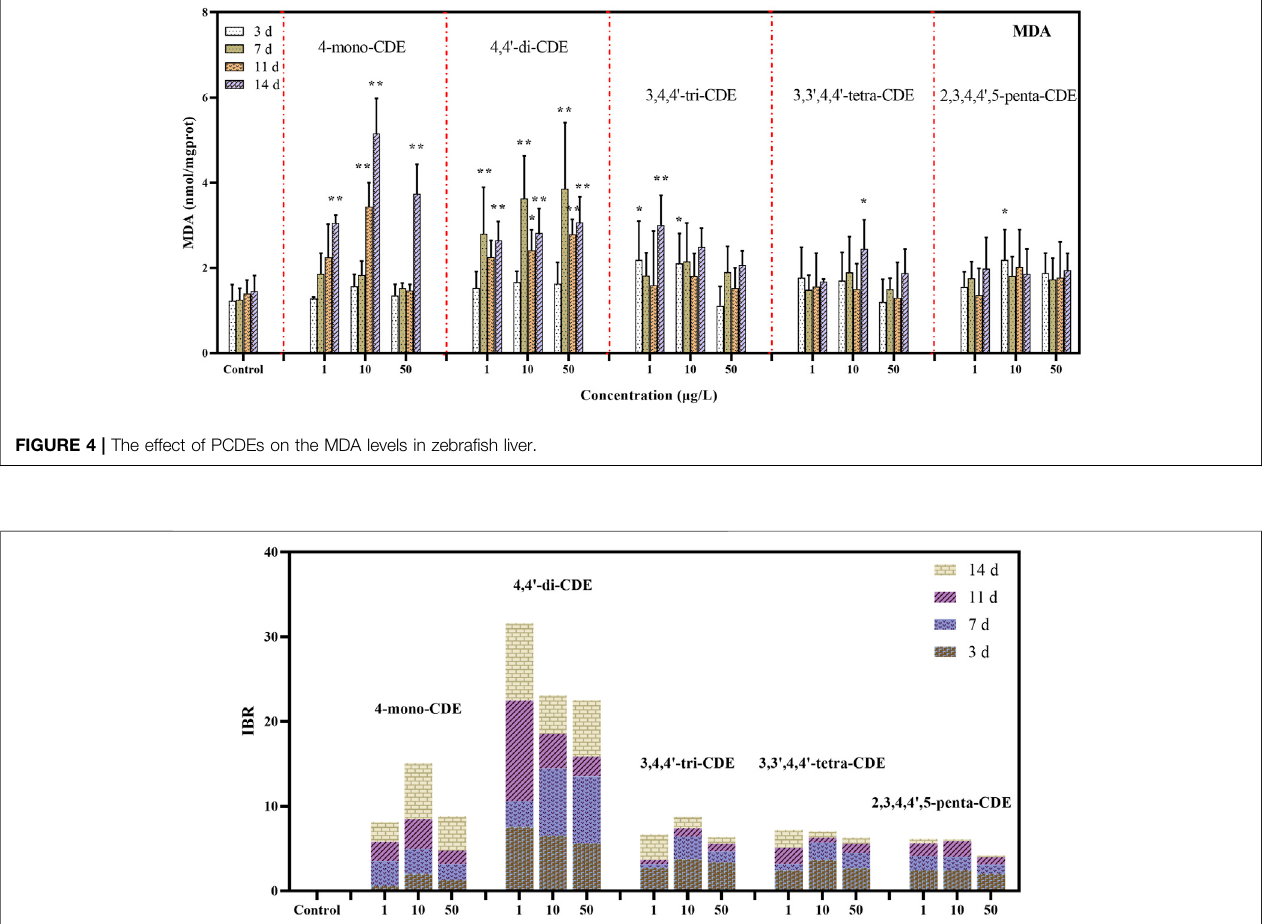
Frontiers in Physiology |